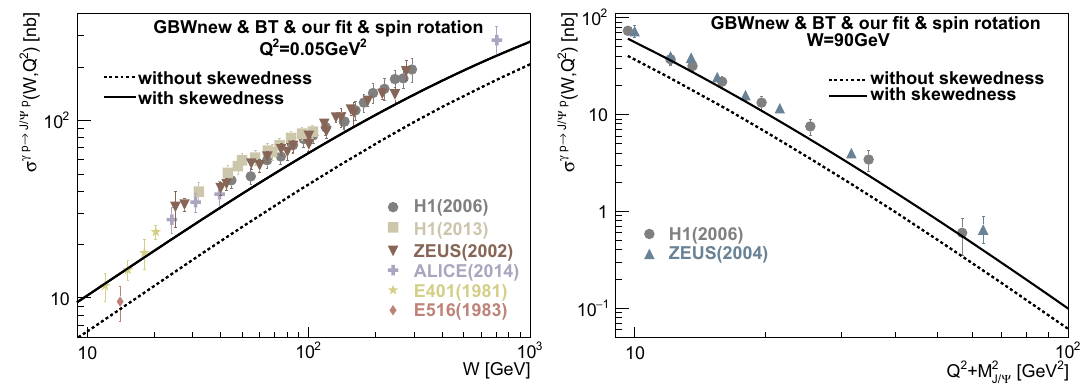
Fig. 26 The same as Fig. 7 but for illustration of the onset of the skew- ness effect as a function of c.m. energy W and the scaling variable Q 2 + M 2 . The model calculations were performed with the J /ψ wave J /ψ